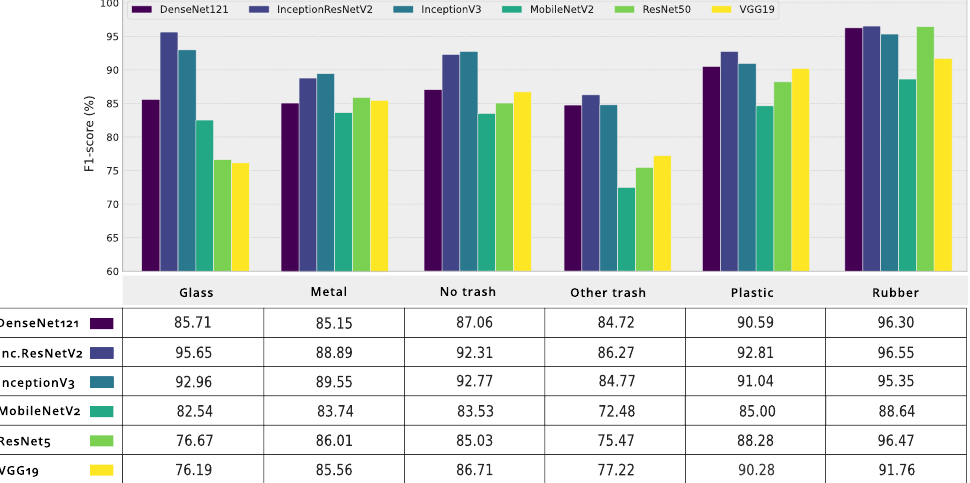
Figure 18. Class-wise F1-scores of FT NN classifiers. Figure 19 shows predictions of the FT Inception model on new images of waste items collected by local divers in the Croatian Adriatic sea, more precisely, in the bays in the area Split and the island of Korˇcula. These local images were not used during the training nor testing. They are the first step toward creating a new local dataset for marine